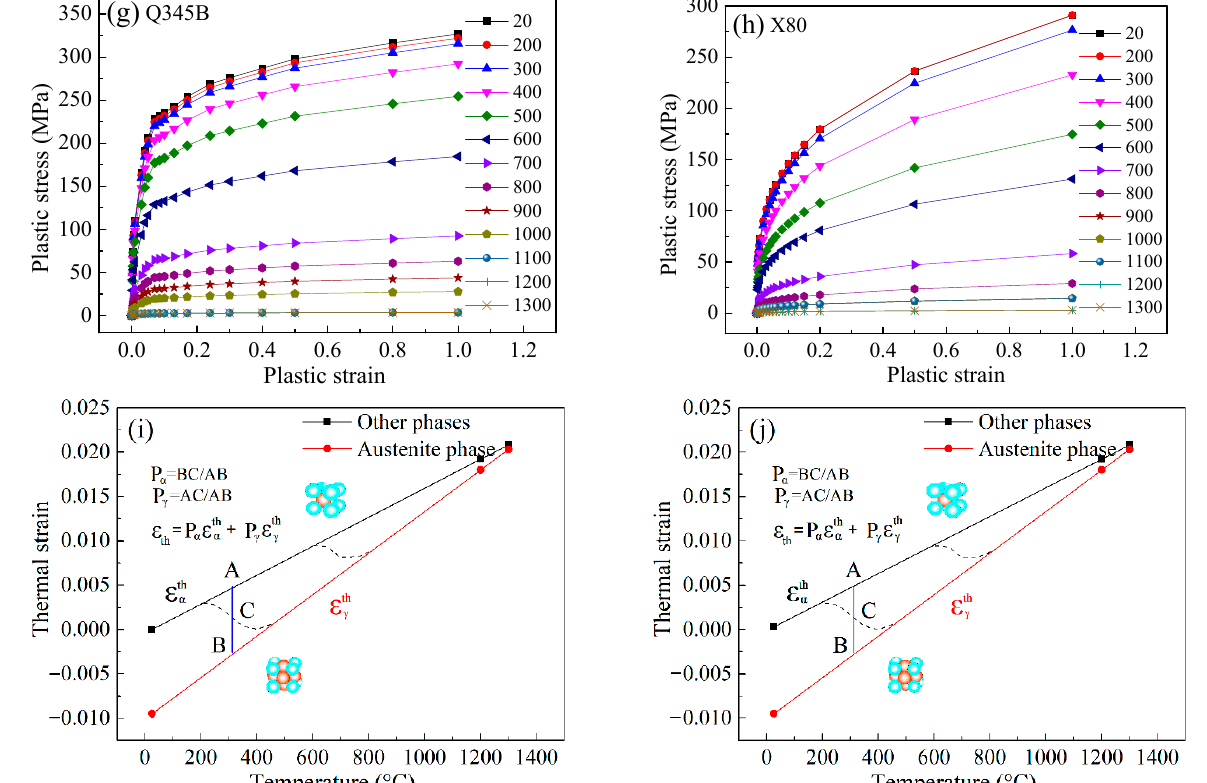
Figure 7. The material properties: ( a ) CCT diagram of X80; ( b ) CCT diagram of Q345B; ( c ) thermal conductivity, ( d ) specific heat, and ( e ) density of X80 and Q345B; ( f ) yield strength; ( g ) plastic strain-stress curve of Q345B; ( h ) plastic strain-stress curve of Q345B X80; ( i ) thermal strain of Q345; ( j ) thermal strain of X80.